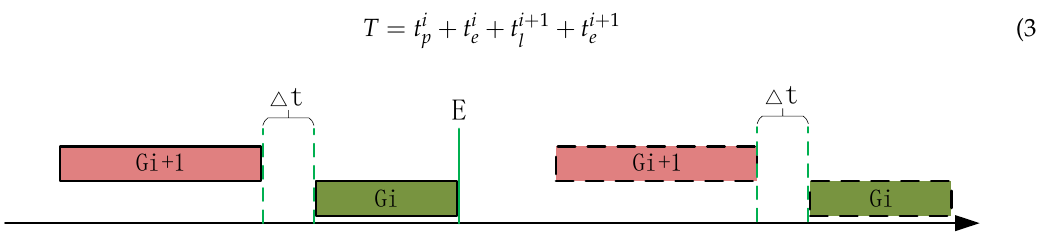
Figure 3. Two groups arrive at the exit successively without congestion.